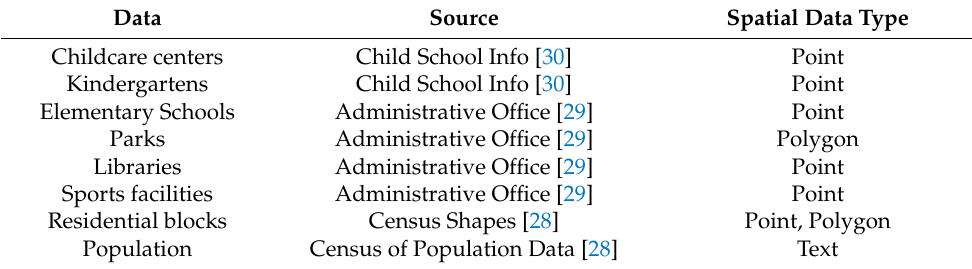
Table 1. Data sources and